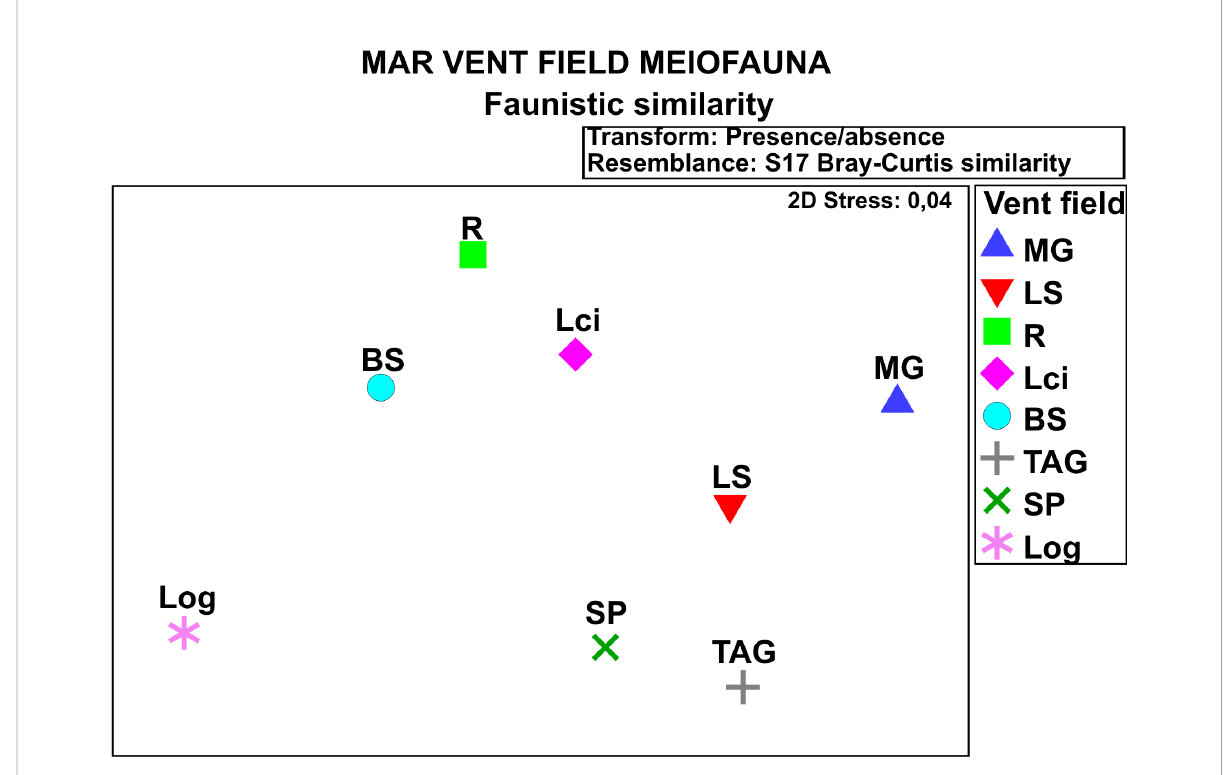
FIGURE 2 An MDS plot of similarity/dissimilarity (presence-absence transformation; group-average sorting) between the composition of meiobenthic assemblages at different MAR vent fi elds (presence-absence transformation; Bray-Curtis similarity); Vent fi eld name symbols: R, Rainbow; BS, Broken Spur; Lci, Lost City; MG, Menez Gwen; LS, Lucky Strike; SP, Snake Pit; TAG, Trans-Atlantic Geotraverse; Log,